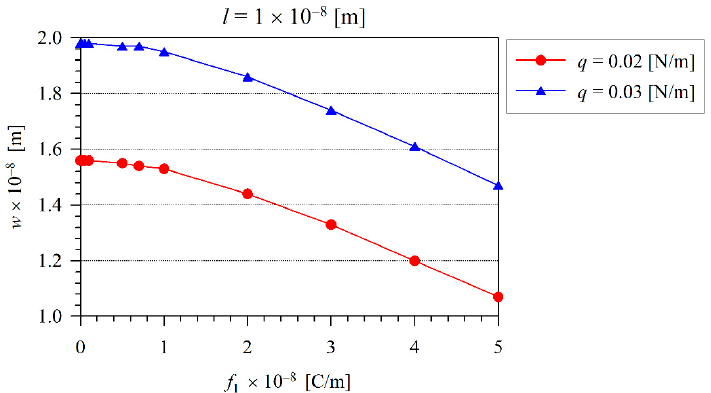
Figure 8. The variation of maximal deflection w with the flexoelectric coefficient for two different loading levels and at the microstructural length-scale parameter l = 1 × 10 − 8 m.